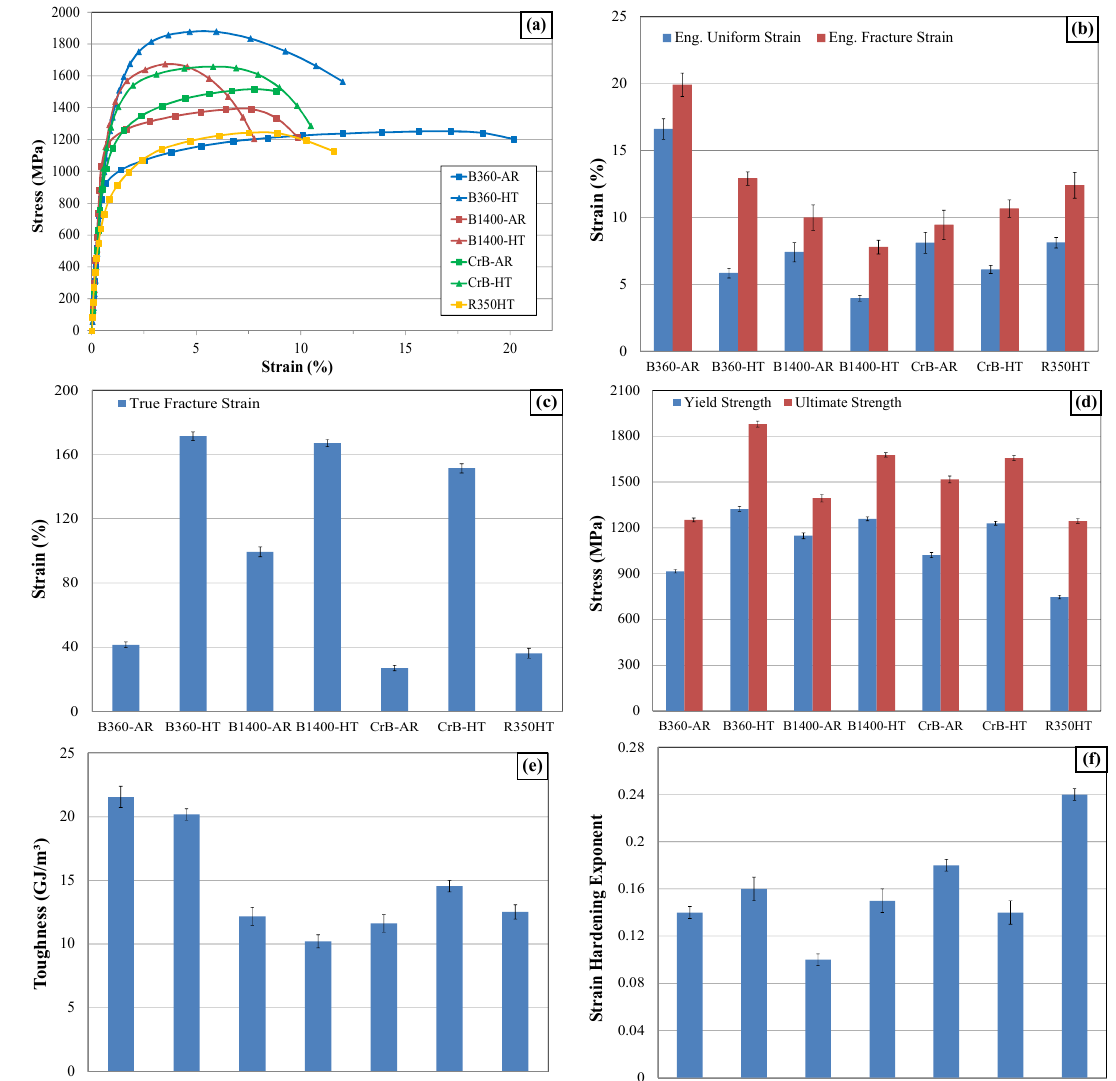
Figure 4. Comparison of mechanical properties of steels using results of the uniaxial tensile tests; ( a ) engineering stress-strain curves, ( b ) engineering uniform strain, engineering fracture strain, ( c ) true fracture strain, ( d ) yield and ultimate strength, ( e ) toughness and ( f ) strain hardening exponent (SHE). Table 3. The values of mechanical (tensile) properties for each steel.